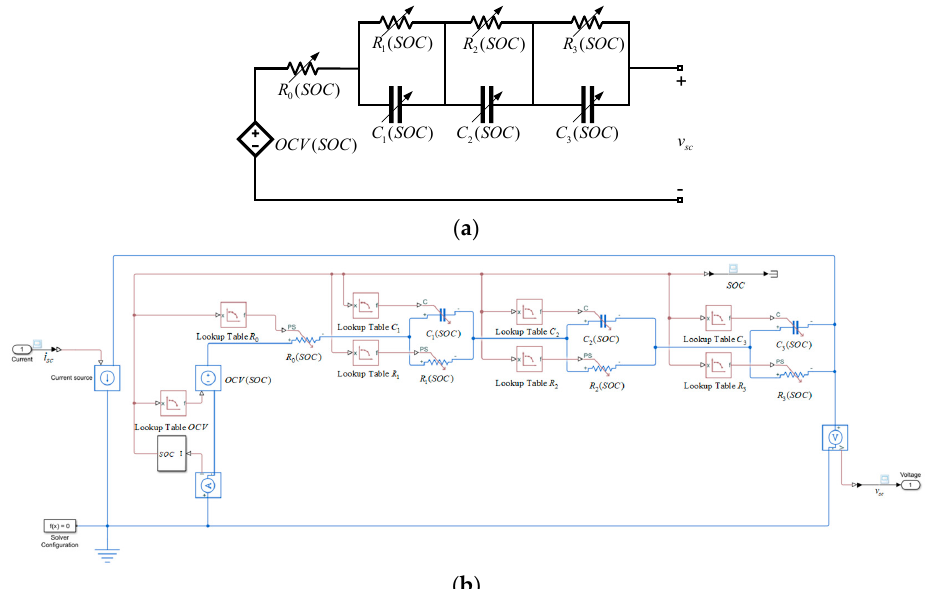
Figure 6. Series model: ( a ) Electric circuit; ( b ) Simscape implementation.